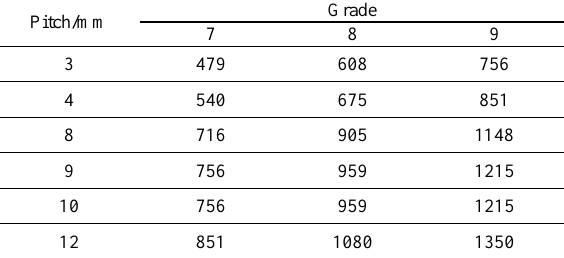
Table 4. Tolerance value in axis Z of box at the end (µm)